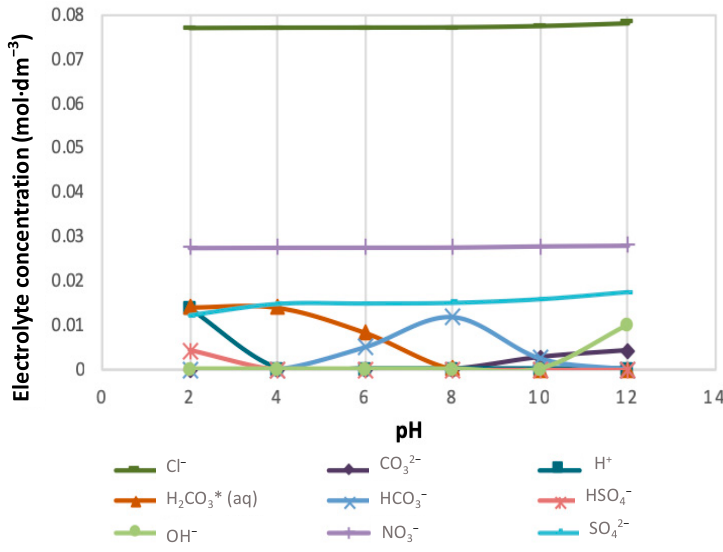
Figure 11. The speciation of cation-free anions in 10SPW.